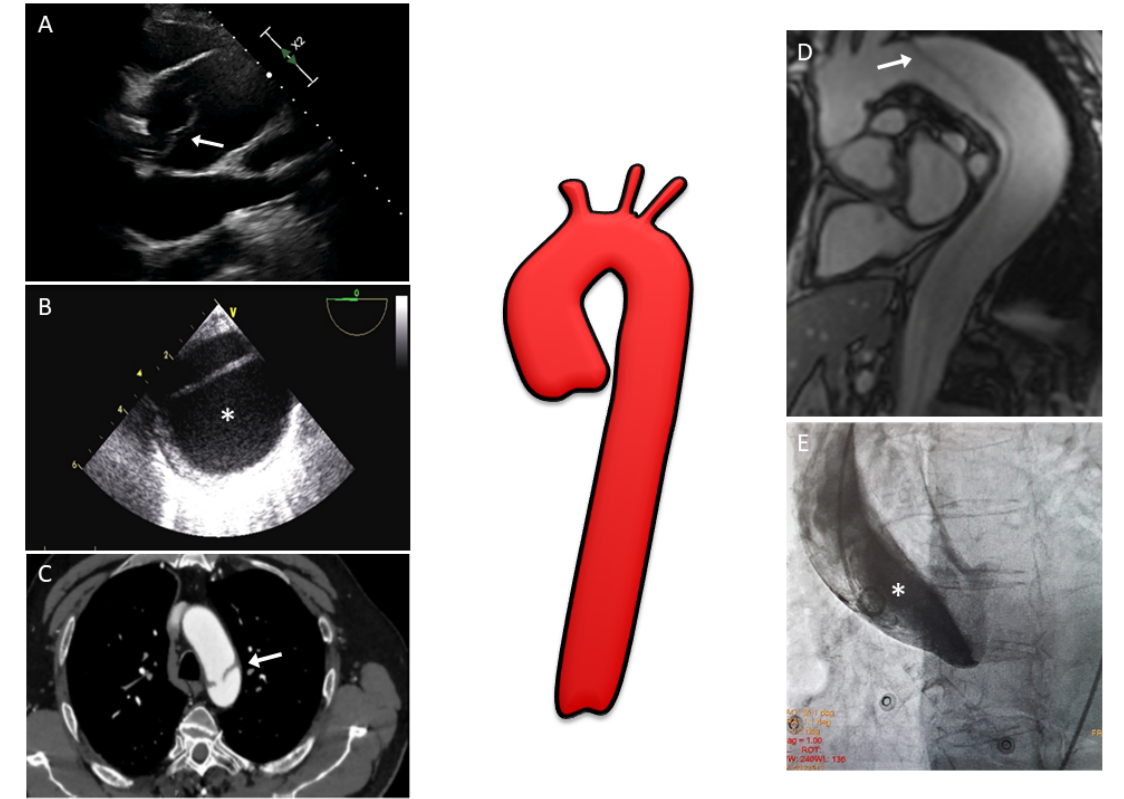
Figure 1. Multimodality imaging assessment of aortic dissection: ( A ) Two-dimensional transthoracic echocardiography showing a linear echo of an intimal flap (arrow) in a dilated aortic root above aortic valve level; ( B ) Two-dimensional transesophageal echocardiography in patients with aortic dissection involving the entire aorta; the false lumen (*) is typically larger and often compresses the true lumen, potentially affecting distal aortic flow; ( C ) CT image with evidence of the intimal tear (arrow) at the level of the aortic arch; ( D ) MRI with SSFP imaging in the oblique sagittal plane showing an intimal flap (arrow) from the aortic arch to abdominal aorta; ( E ) Aortic angiography performed in a patient with suspected inferior ST-segment elevation myocardial infarction revealing a type A aortic dissection (one may note that the pigtail catheter is located in the false lumen (*) of the dissection). CT, computed tomography; MRI, magnetic resonance imaging; SSFP, steady-state free